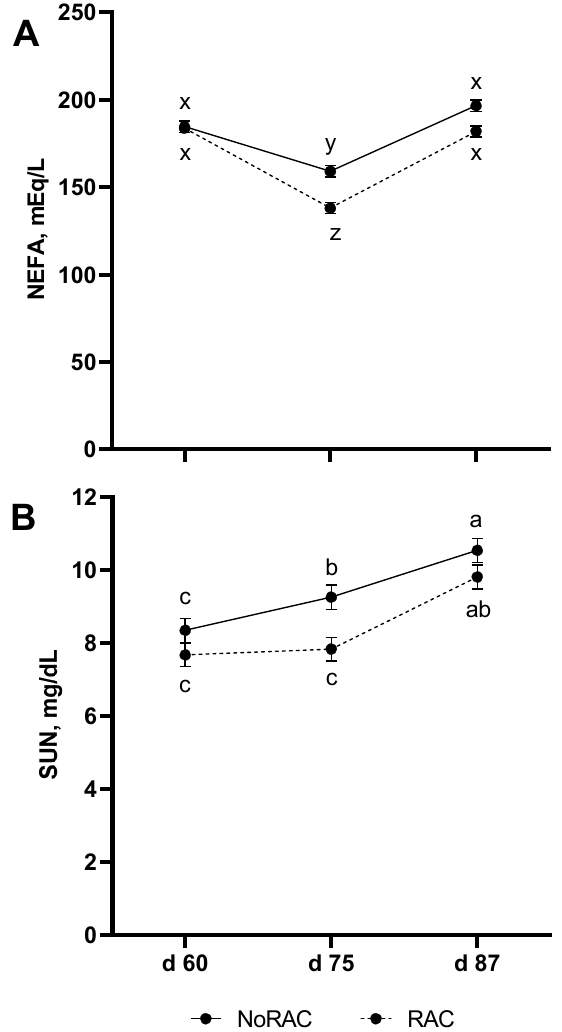
Figure 2. Beta agonist (BA) supplementation and day of sampling influences serum non-esterified fatty acid (NEFA) and serum urea nitrogen (SUN) concentrations. Ractopamine hydrochloride was supplemented for 28 day prior to harvest, starting on day 61, at 0 (NoRAC) or 300 (RAC) mg · steer − 1 · day − 1 . ( A ) Serum NEFA concentrations tended to decrease on day 75 for both BA treatments with lesser concentrations for RAC. Both BA treatments regained initial concentrations by day 87 (BA × Day; p = 0.06). Superscripts (x, y, z) that differ tend ( p < 0.15) to be different. ( B ) Serum urea nitrogen concentrations increased across sampling date for NoRAC, while SUN did not differ for RAC between day 60 and 75 but increased from day 75 to 87 (BA × Day; p = 0.05). Superscripts (a, b, and c) are different ( p < 0.05).